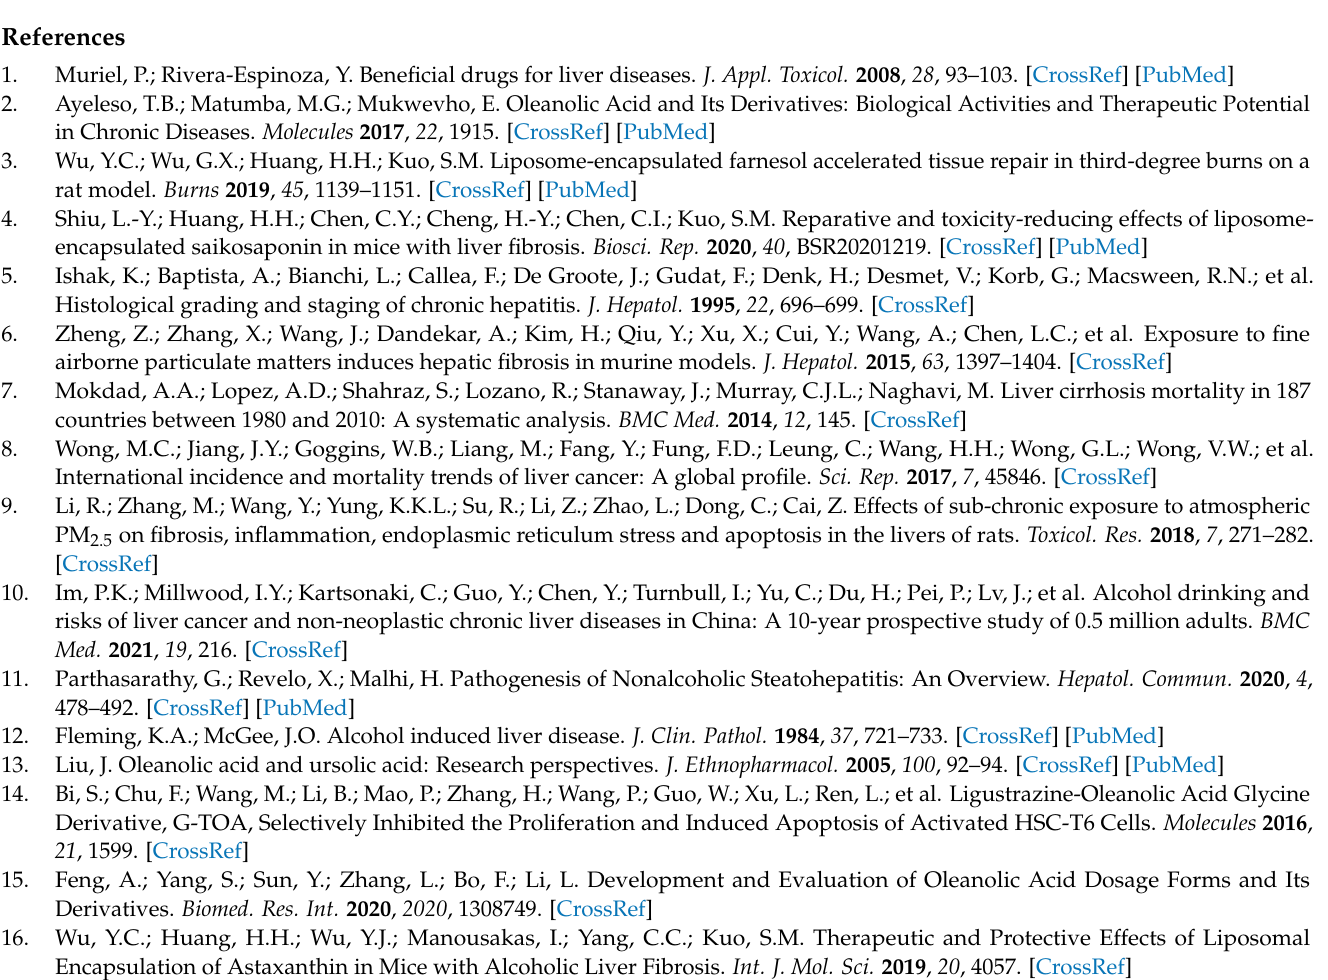
Figure S4. H&E staining and Masson’s trichrome staining of the sections of PM2.5 and alcohol–induced inflammation liver treated with OA, Lipo-OAs, or pure liposomes (magnification, 200 × ): after ( a ) 4 and ( b ) 6 treatment weeks. The geometric figure was the representative area of: Patchy steatosis (white box), steatosis (black arrow), Mallory bodies and ballooning cells (black arrowhead), necrosis (black circle), single-cell apoptosis (black triangle), and pericellular fibrosis (black